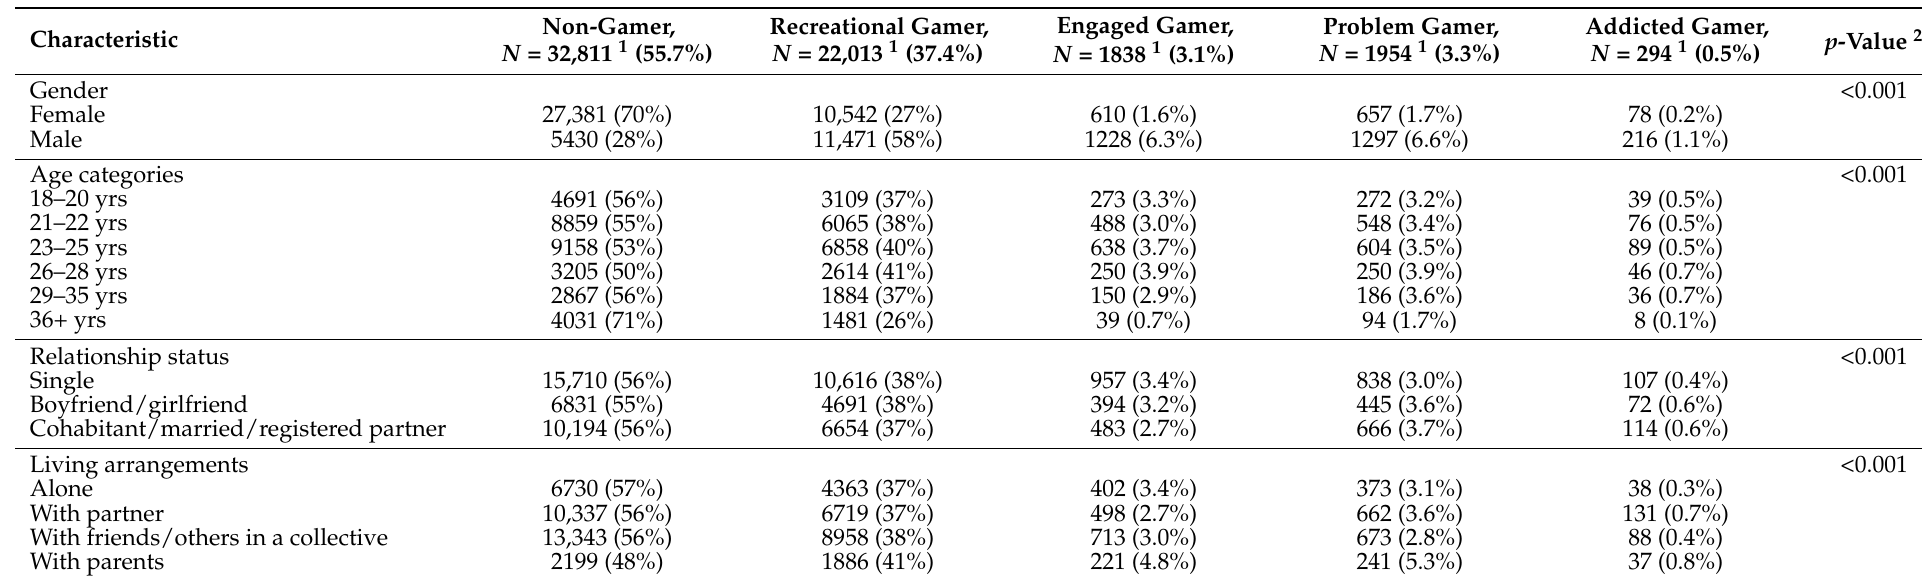
Table 1. Descriptive statistics.